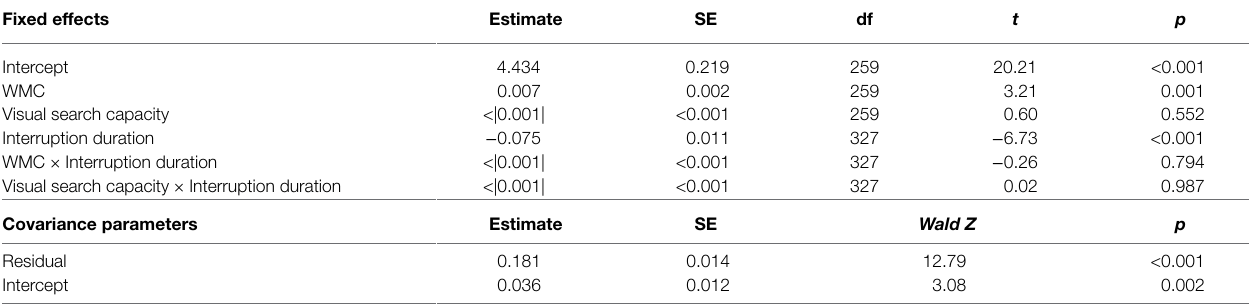
TABLE 1 | Summary of the multilevel regression for accuracy.